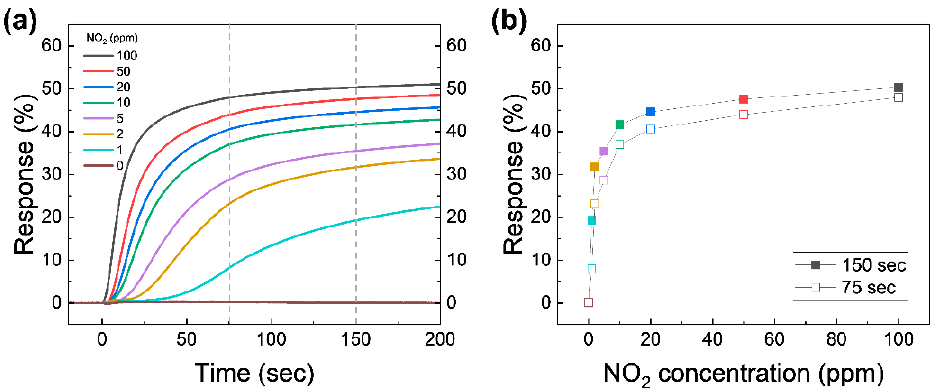
Figure 4. ( a ) Capacitive response as a function of time for various NO 2 concentrations. Atmospheric pressure is reached in 75 s. The gray vertical dashed lines are marked at 75 and 150 s for comparison. ( b ) The response at t = 75 s (reached atmospheric pressure; open symbols) and 150 s (closed symbols) from ( a ) as a function of the NO 2 concentration.